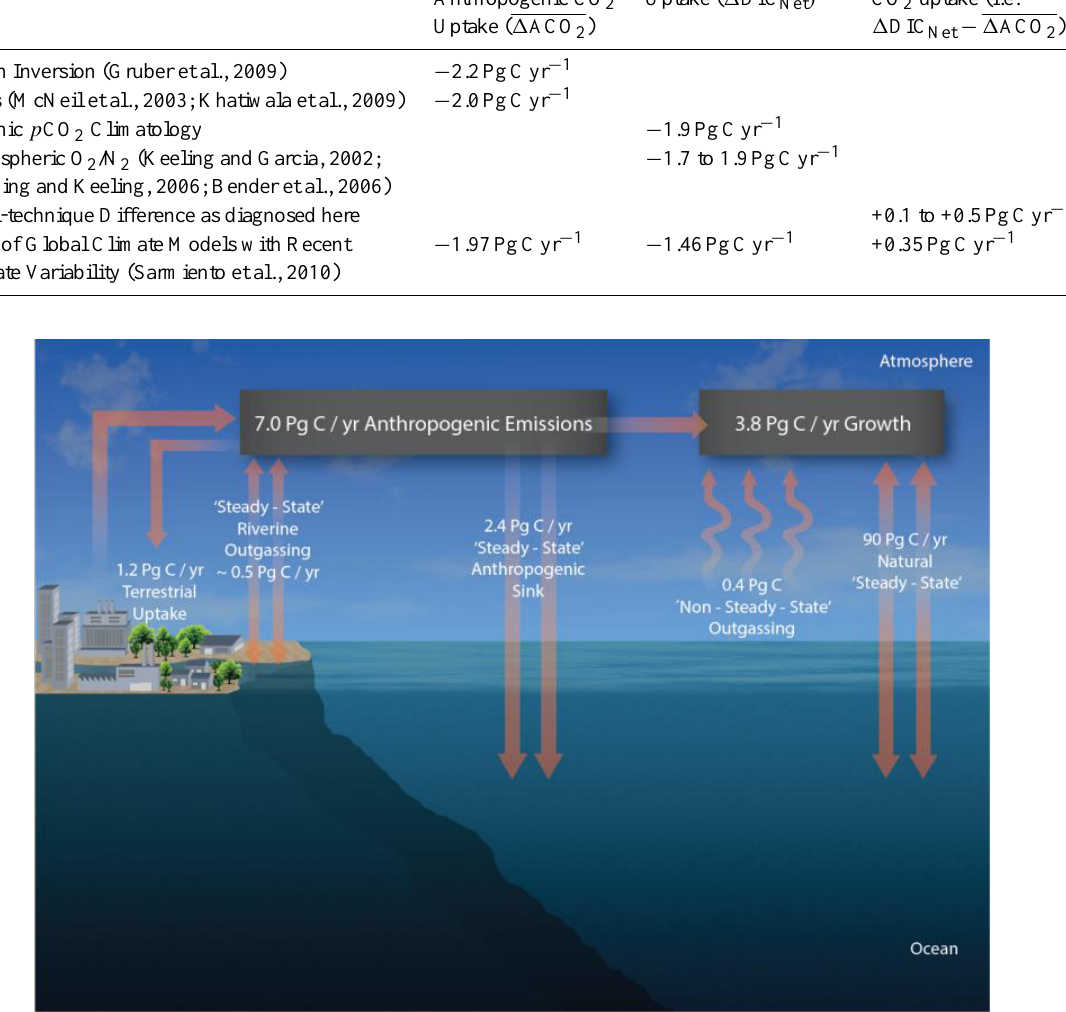
Table 2. Different estimates for the time-evolving oceanic CO 2 uptake between 1990–1999 assuming no uncertainty. Data-based Technique